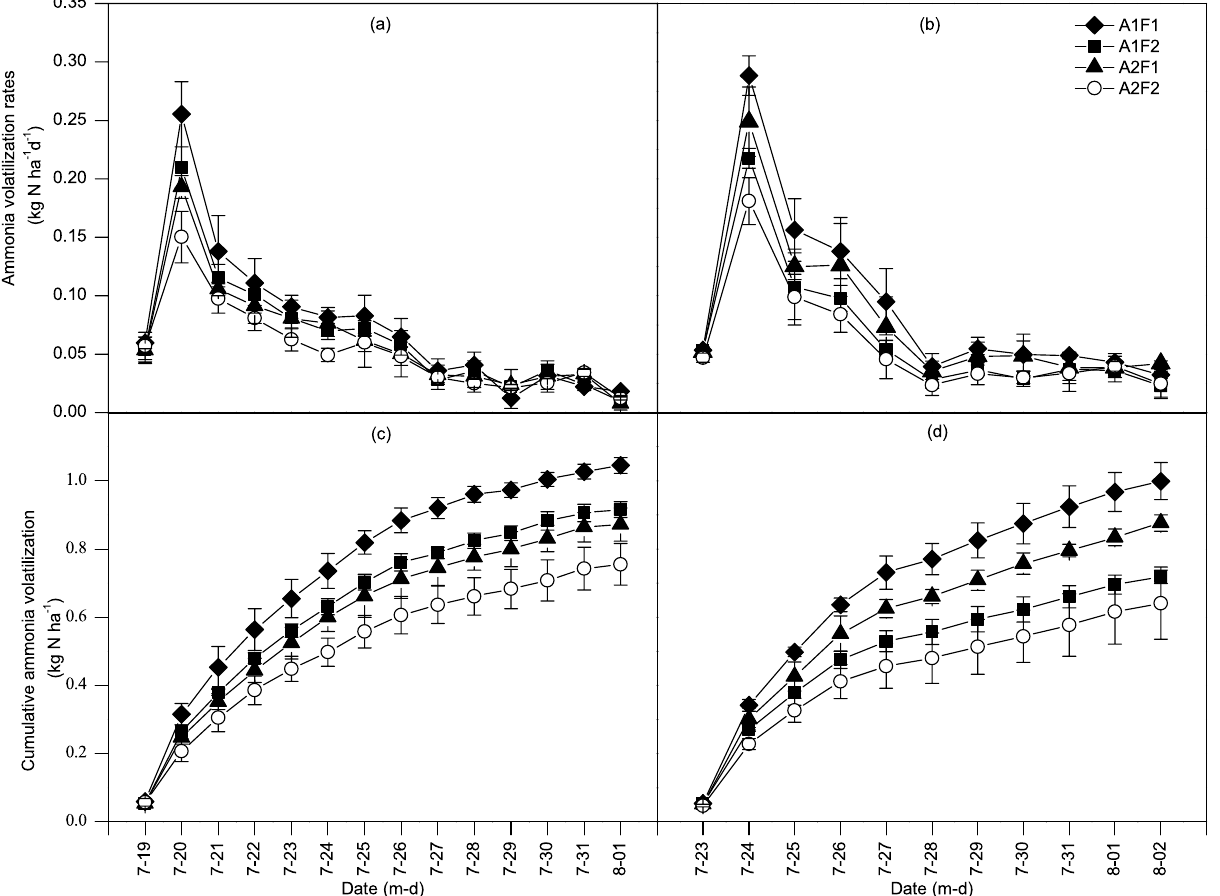
Figure 6. Ammonia volatilization rates as influenced by dripline spacing and fertilization rate treatments of summer maize at the seven-leaf stage in 2017 ( a ) and 2018 ( b ). Cumulative ammonia volatilization as influenced by dripline spacing and fertilization rate treatments of summer maize at the seven-leaf stage in 2017 ( c ) and 2018 ( d ). See Fig. 2 and Table 2 for treatment description. Graphs were created using Origin software version 2021 (Origin Lab Ltd., Guangzhou, China). Origin is used herein under license. Copyright OriginLab Corporation. All rights reserved. For more information about Origin software, please visit www. origi nlab.